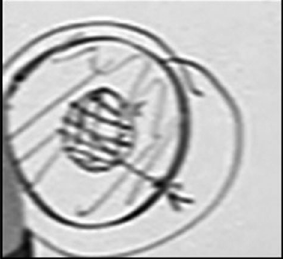
FIG. 7. Picture drawn by students in the hypothetical debate